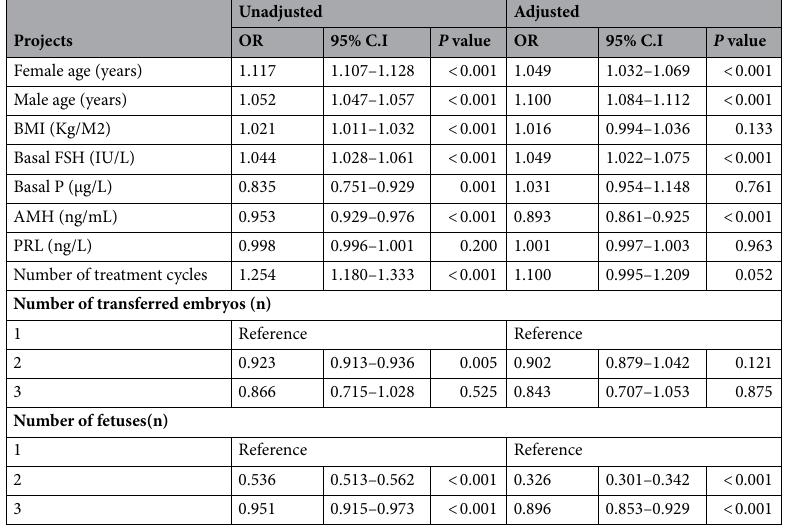
Table 2. Logistic regression analysis of factors related to spontaneous abortion. Data are shown as means ± standard deviation. BMI, body mass index; FSH, follicular-stimulating hormone; P, progesterone; AMH, anti-Mulller hormones; PRL, prolactin; Adjusted for female age, male age, body mass index, follicular- stimulating hormone, progesterone, anti-Müllerian hormon, prolactin, number of treatment cycless, number of transferred embryos and number of fetuses except the subgroup